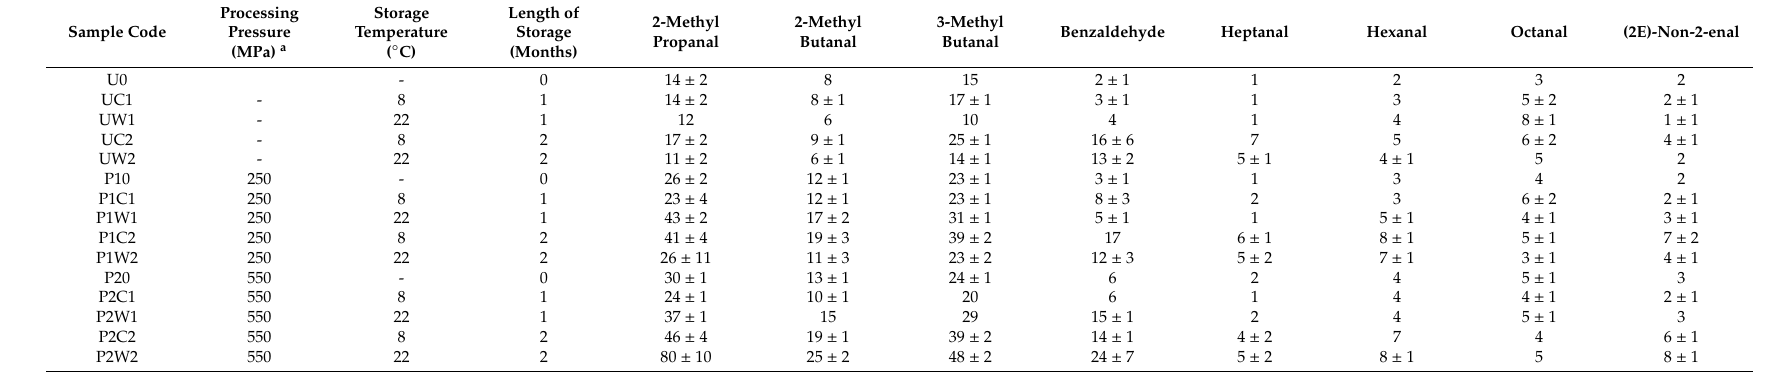
Table 2. Concentrations of staling aldehydes ( µ g / L) in beers processed at di ff erent pressures (250 MPa or 550 MPa) and stored in cold (8 ◦ C) or at room temperature (22 ◦ C) for 1 or 2 months. Samples are coded according to: U / P1 / P2 relates to the type of processing—untreated, 250 MPa, 550 MPa, respectively; C / W relates to “cold” (8 ◦ C) or “warm” (22 ◦ C) storage temperature and the last letter 0 / 1 / 2 relates to the storage time—0, 1 or 2 months. Sample